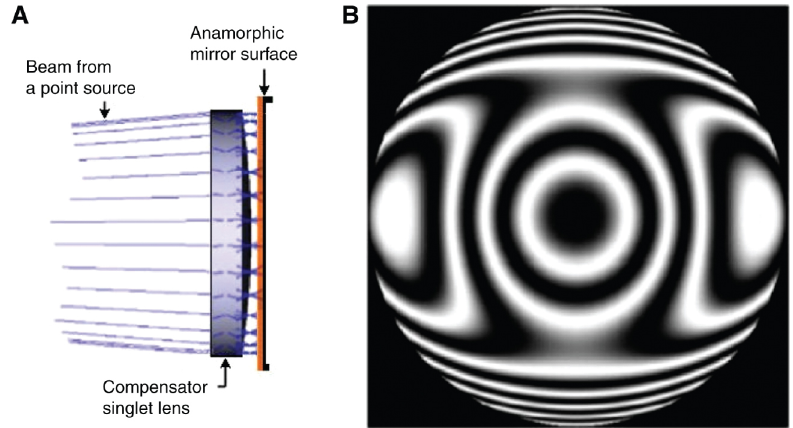
Figure 20: Null-test single lens aberration compensator for the freeform primary mirror. (A) Measurement scheme mounting of the lens with convex surface facing the optical surface. (B) Simulated He-Ne interferogram of remaining fringes to be calibrated